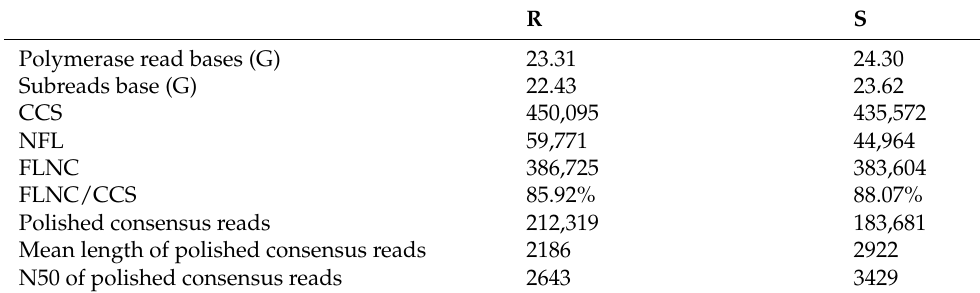
Table 1. Summary of full-length transcript sequence